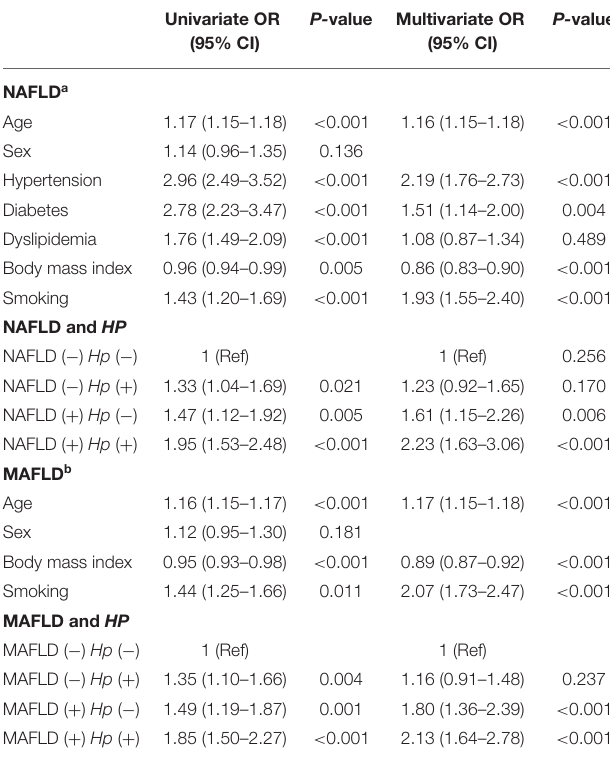
TABLE 2 | Univariate and multivariate analyses of the risk for arterial stiffness in the total population. Univariate OR P- value Multivariate OR